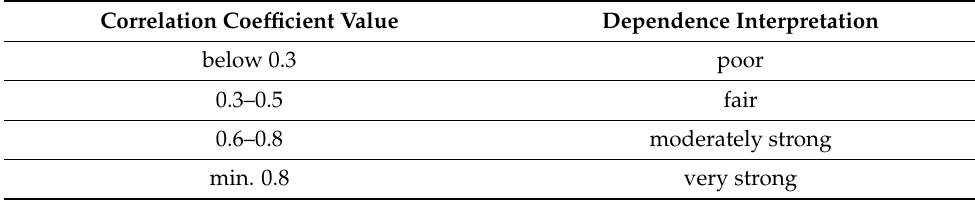
Table 2. Interpretation of correlation coefficient